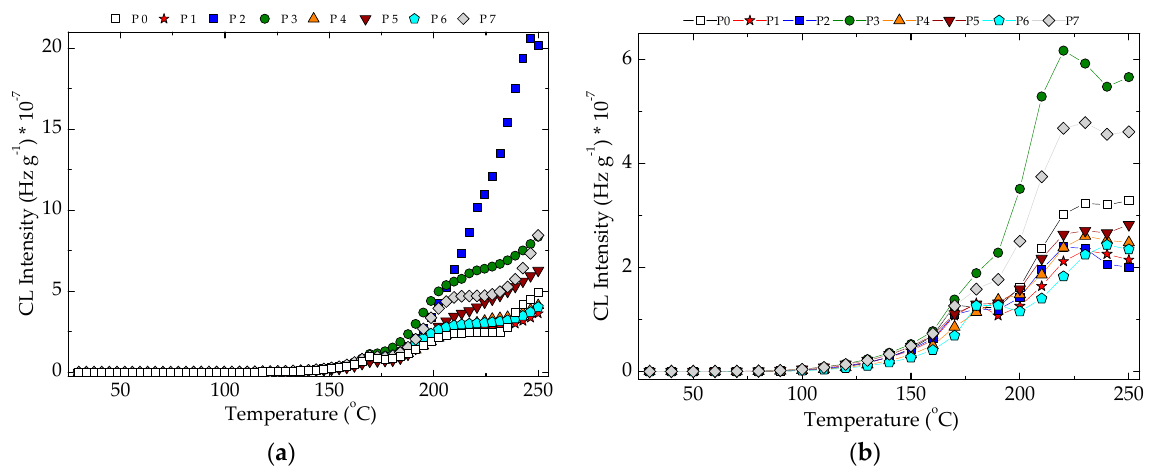
Figure 7. Nonisothermal CL spectra recorded on PP/modified POSS powder. ( a ) γ -dose: 25 kGy; heating rate: 10.0 °C min − 1 ; ( b ) γ -dose: 50 kGy; heating rate: 15.0 °C min − 1 .